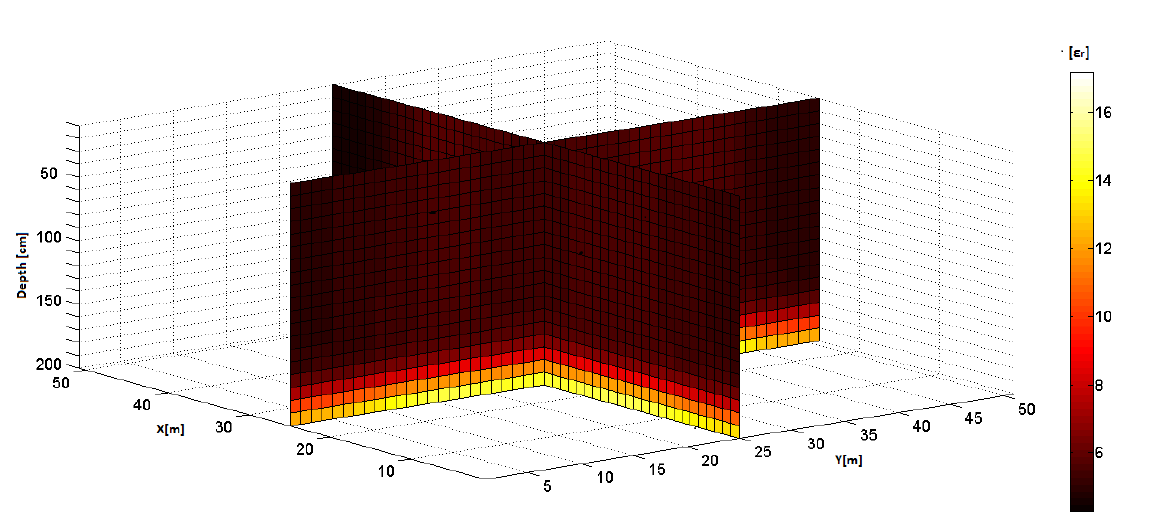
Figure 8. Relative permittivity section in sand soil